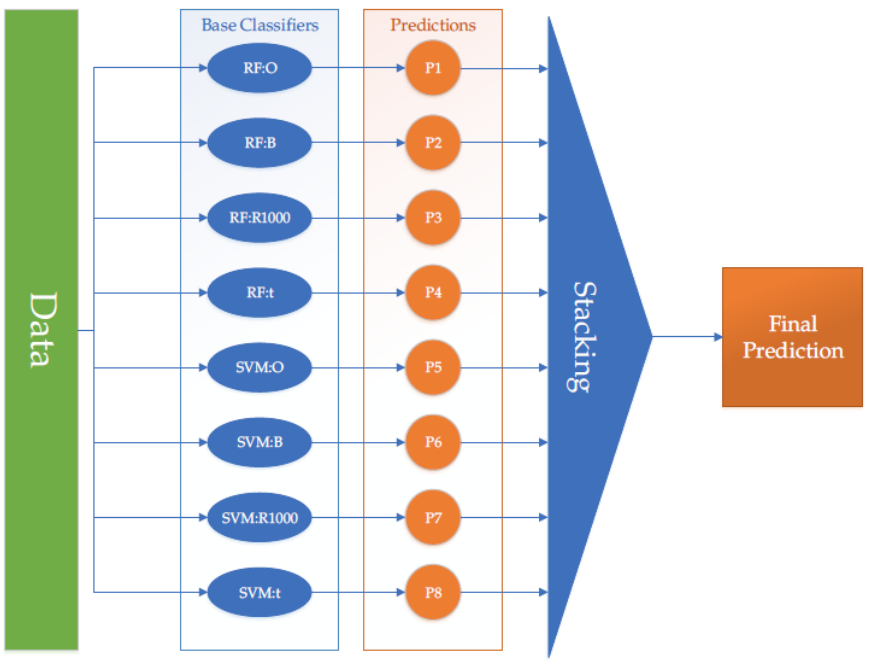
Figure 2. Diagram of the Stacked Generalization